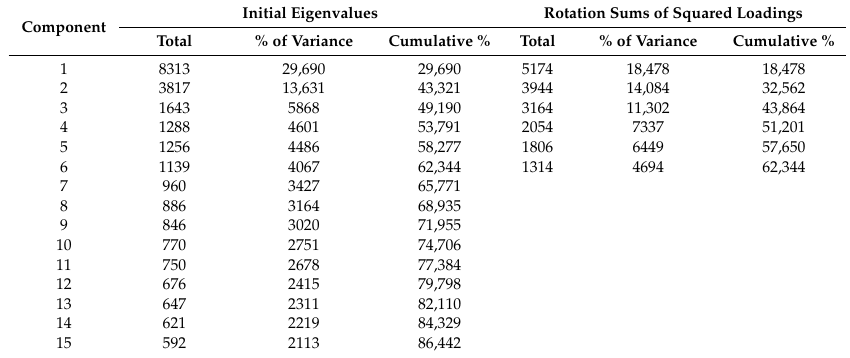
Table A1. Total Variance Explained for Principal Component Analysis. Source: